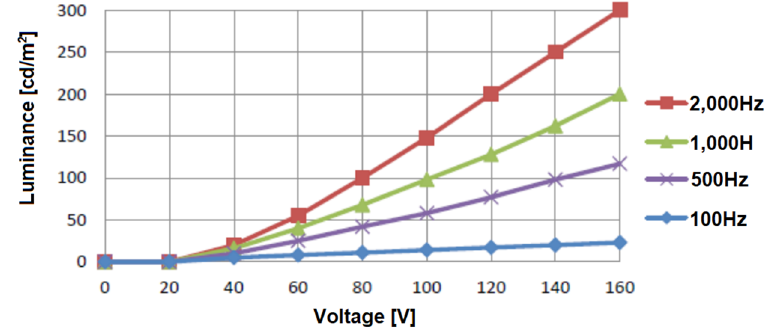
Figure 8. Luminance values for di ff erent AC voltages and di ff erent current frequencies.